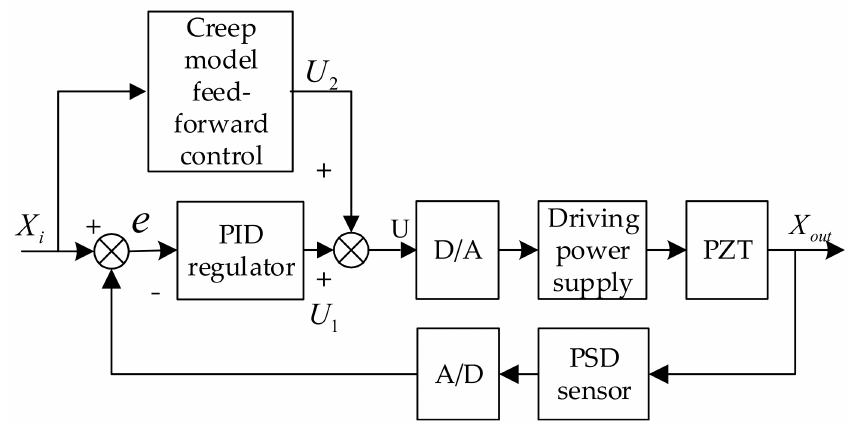
Figure 9. PID closed loop control chart based on feedforward